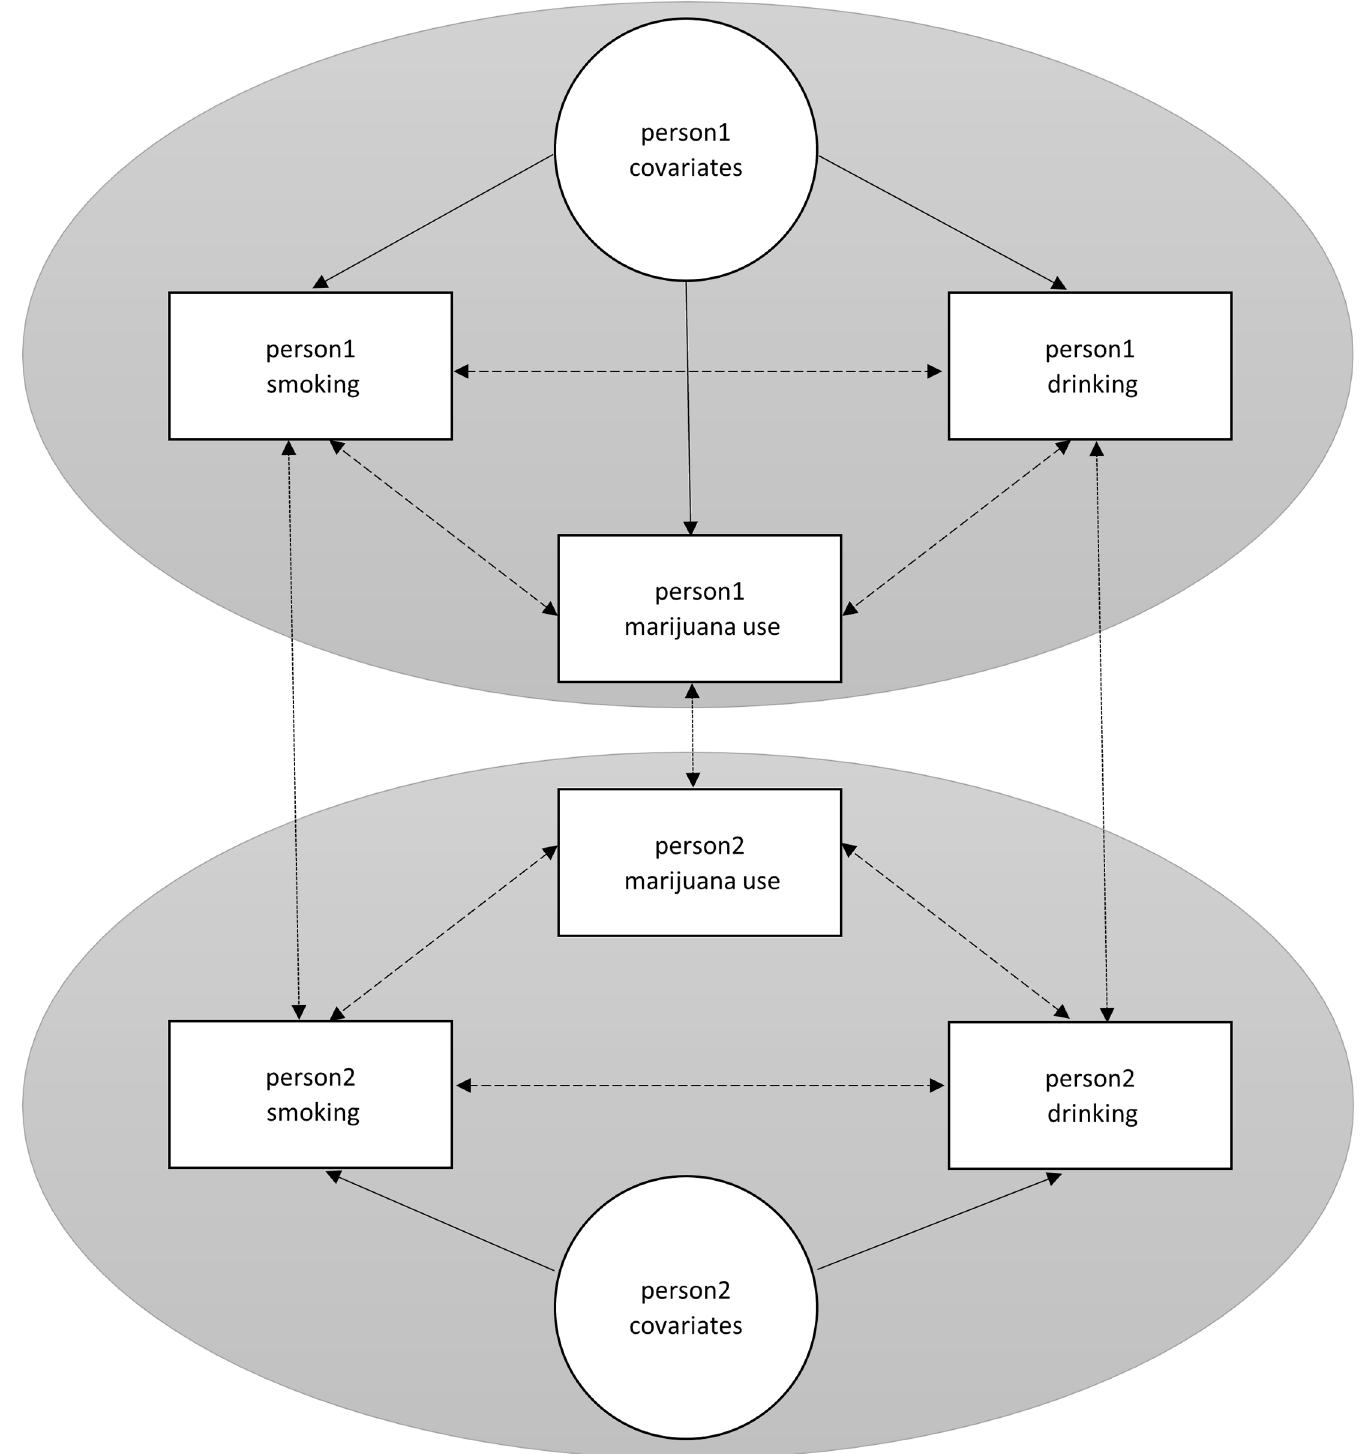
Fig 1. Multiple relationships in a hypothetical simple 2-person world of three substance use behaviors.